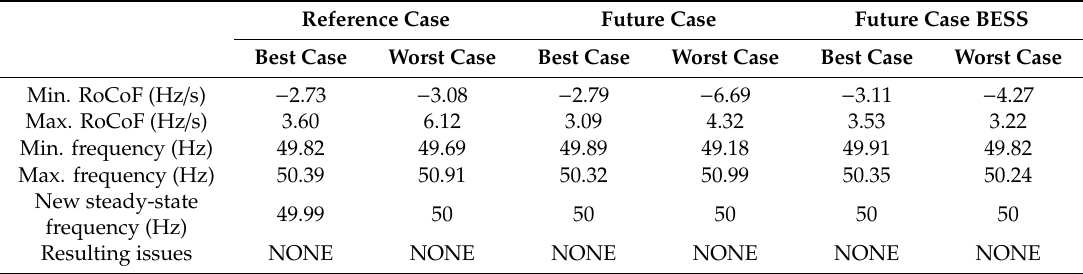
Table 9. Results of three-phase short-circuit (3ph) short-circuit for all scenarios and cases. Reference